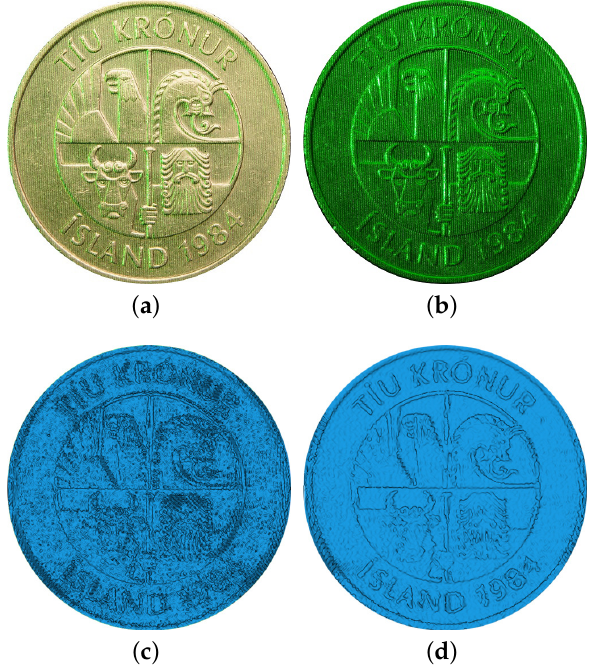
Figure 5. Illuminated coin and its retrieval as background illuminance E = 1000 Lux for indoor measurement. ( a ) without filtering; ( b ) with filtering; ( c ) retrieval using the image of ( a ); ( d ) retrieval using the image of ( b